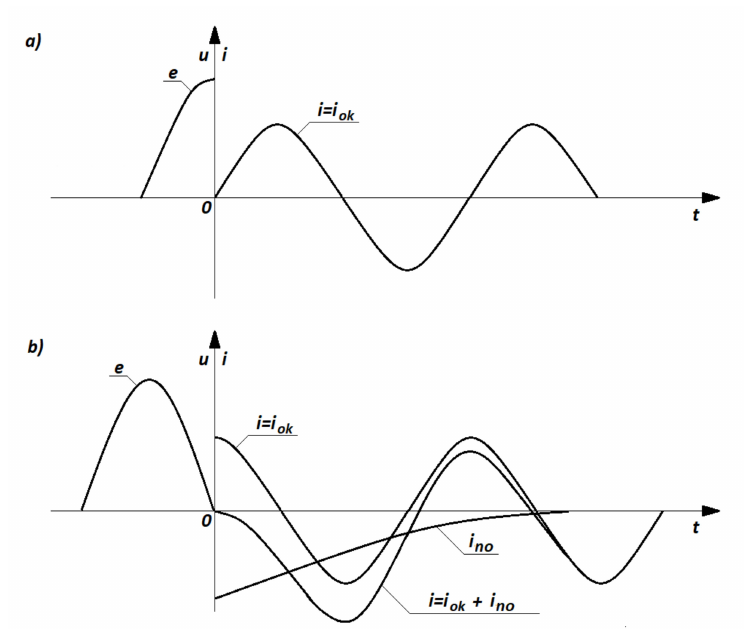
Figure 3. Example of short circuit current waveform: ( a ) without non-periodic component, ( b ) with the highest rate of non-periodic component, i no —non-periodic component, i ok —periodic